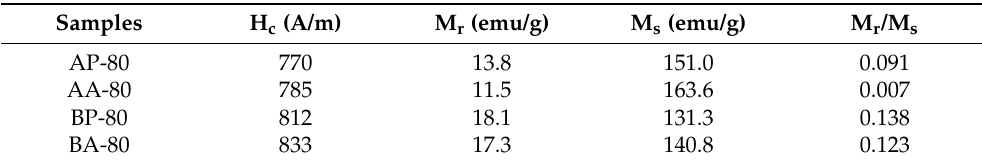
Table 5. Relevant parameters determined from the magnetic hysteresis loops of samples AP-80, AA-80, BP-80, and